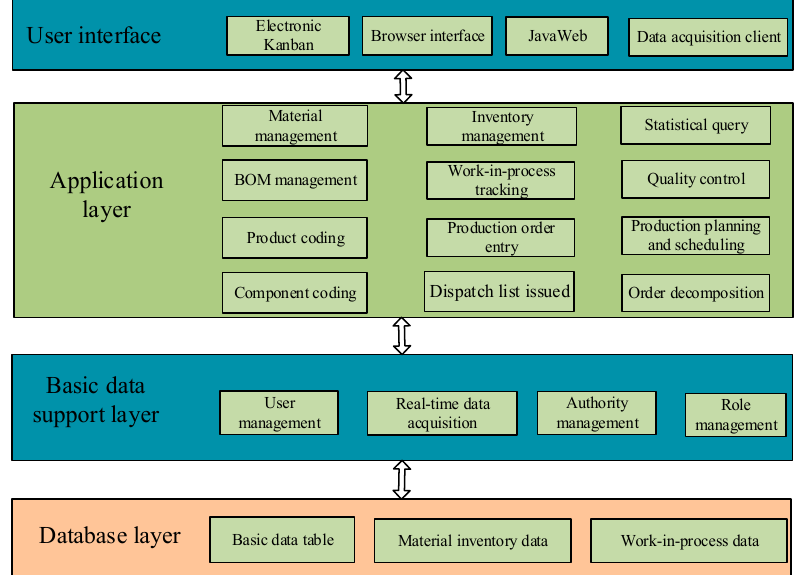
Figure 6. The overall framework of MES.